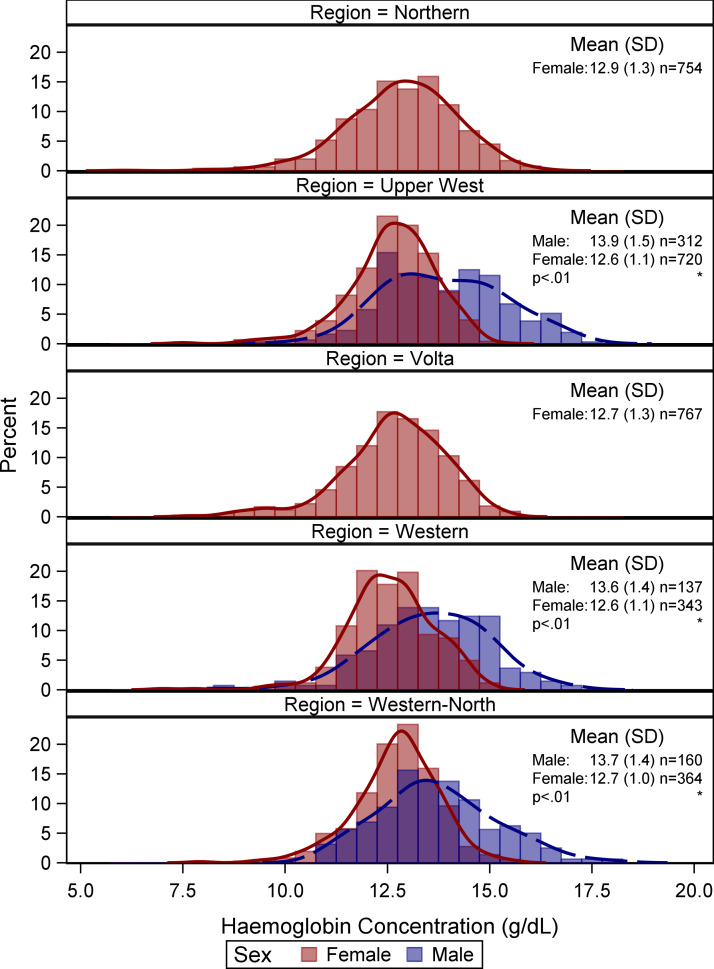
Distribution of haemoglobin concentration among adolescent girls and boys in Ghanaian Schools by regions (n 2948). Note: Unweighted descriptive statistics and histograms. *P < 0⋅01. Complex survey procedures and weights used to account for clustering in testing the differences in mean haemoglobin concentration between girls and boys.